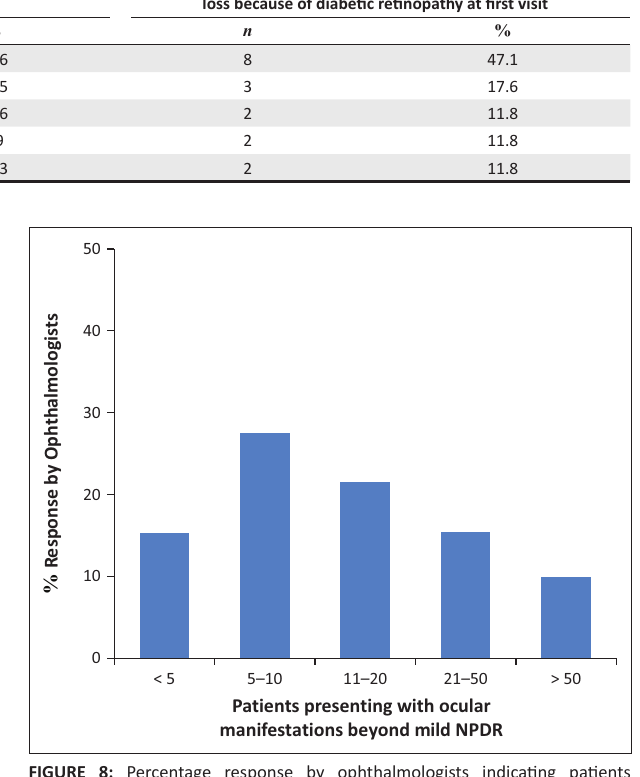
FIGURE 8: Percentage response by ophthalmologists indicating patients presenting with ocular manifestations beyond mild non-proliferative diabetic retinopathy.